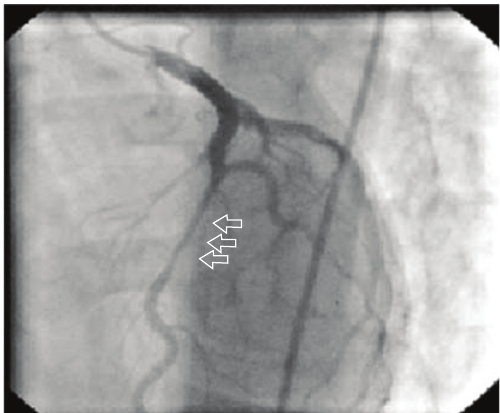
Figure 2: Myocardial bridging at the mid portion of the LAD and narrowing during systole.